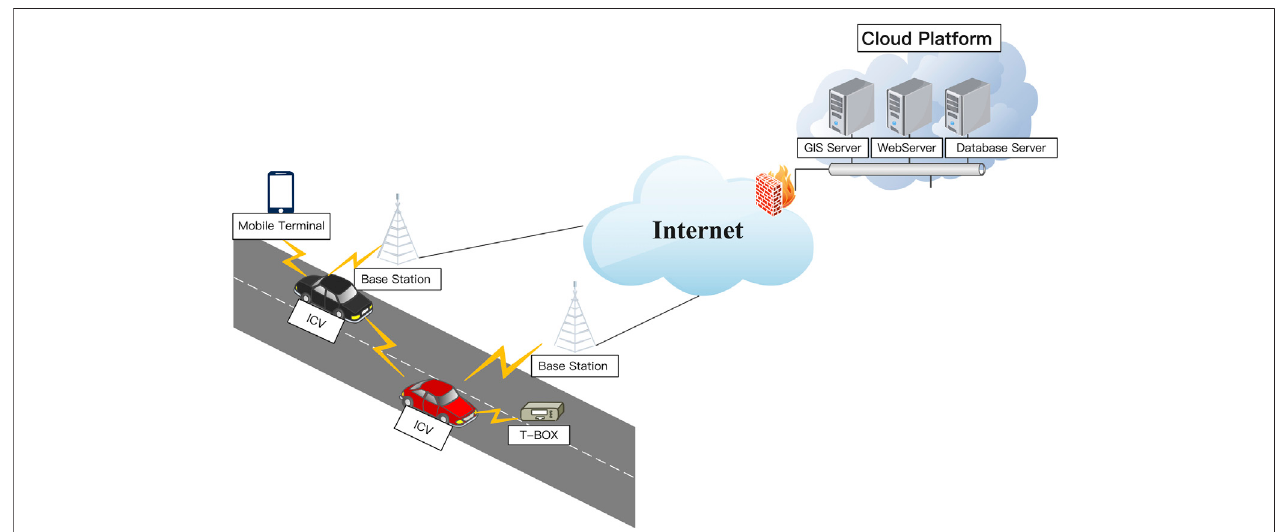
FIGURE 4 | Typical attack